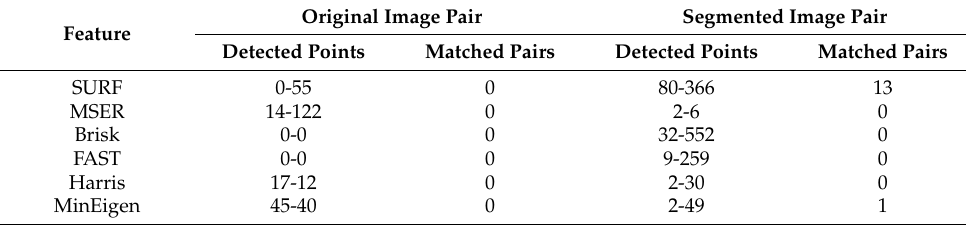
Table 2. Feature-based real world images registration experiment.